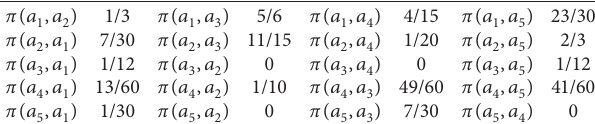
Table 9: Environmental criteria priority index.